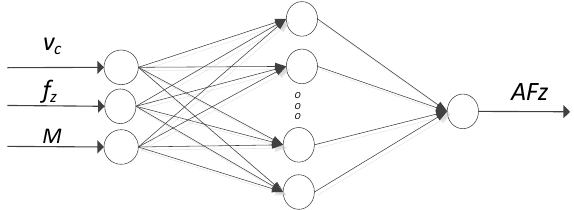
Figure 8. Schematic structure of the modeled neuron networks.